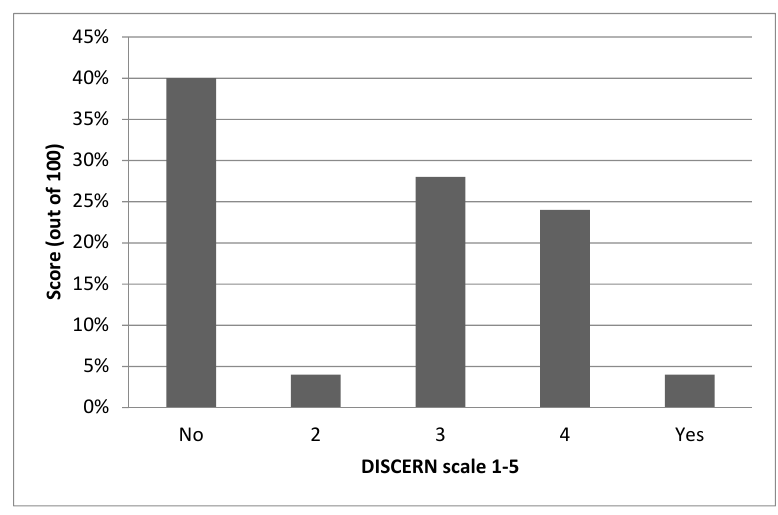
Figure 4. Clarity of sources of all included websites by LS.